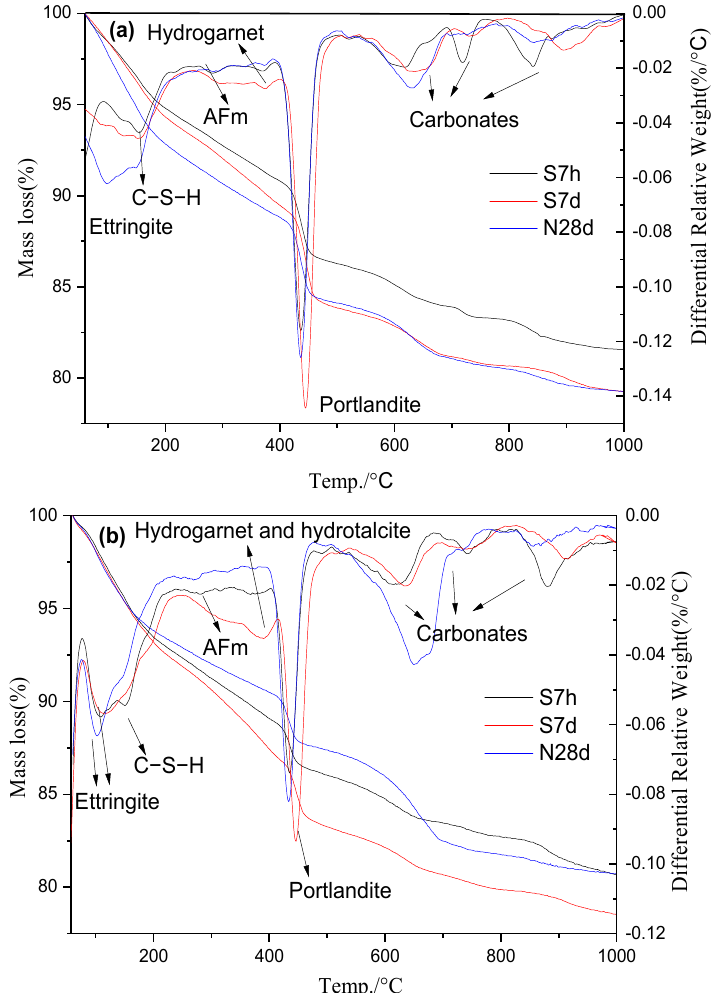
Figure 11. TG / DTG curves of Ref ( a ) and G20 ( b ) under different curing conditions.